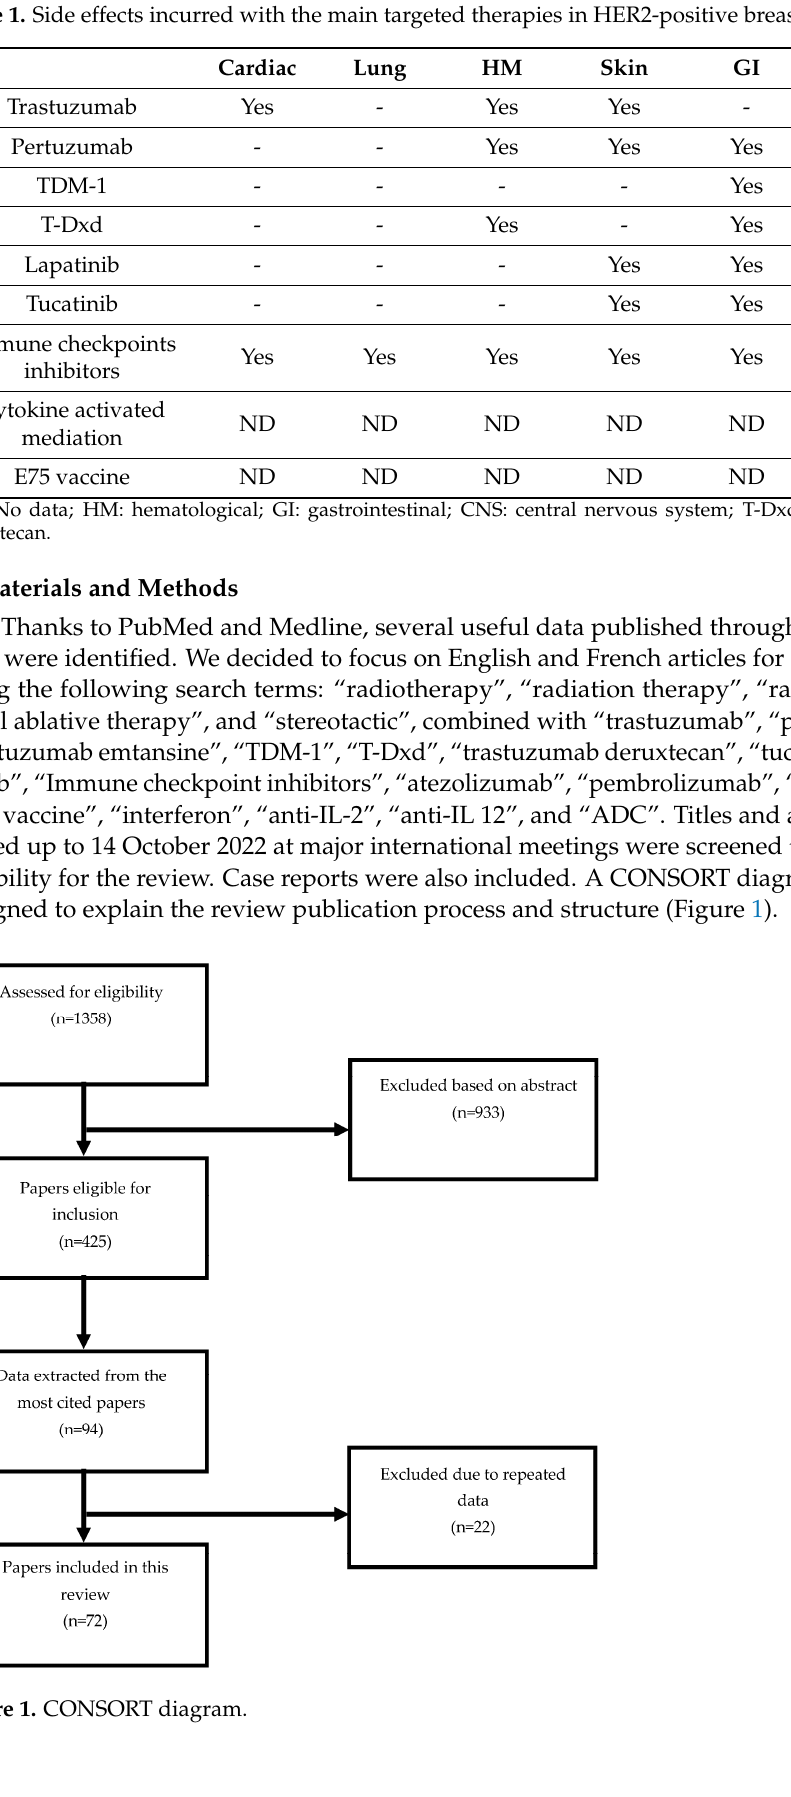
Table 2. Guidelines, precautions, and advice for humanized monoclonal antibody (MAB) targeting HER2. MAB